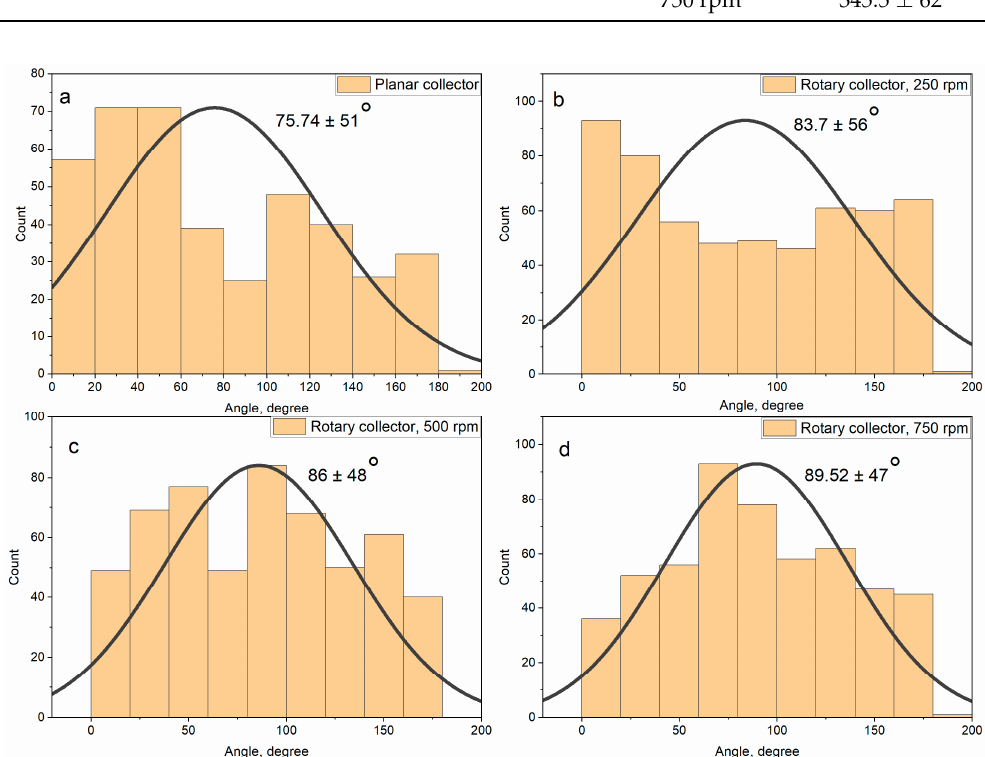
Figure 3. The influence of the collector type and the rotation speed on the orientation of nanofibers. Nanofibers have been collected at the following parameters: ( a ). Sample 3: 20 kV, 150 mm, 0.72 mm,